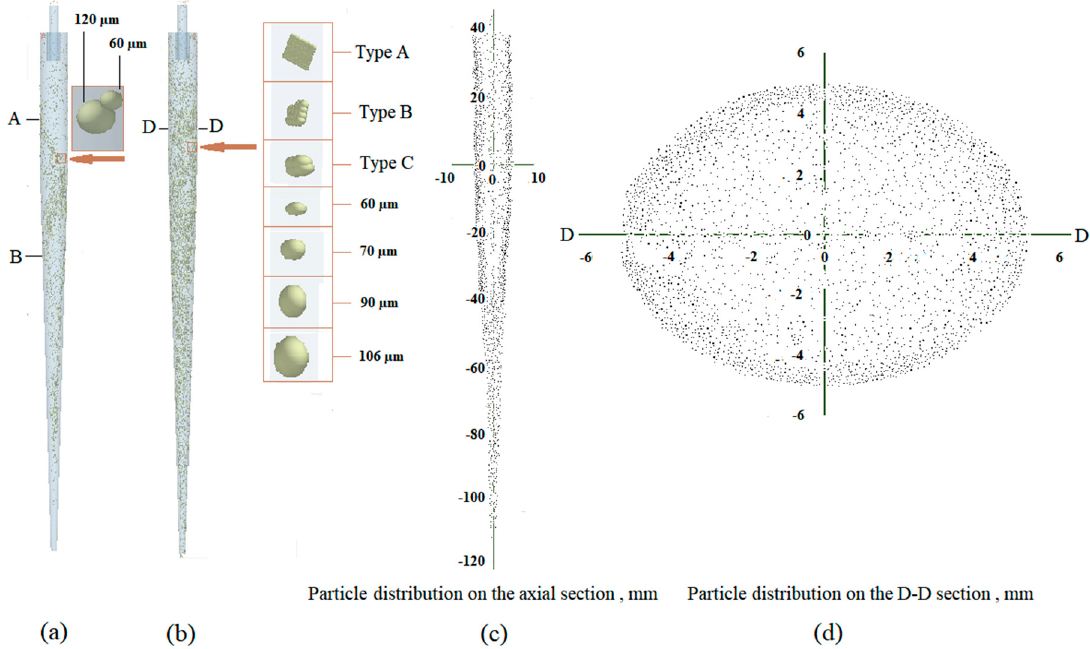
Figure 5. Sand particle distribution in simulation: ( a ) the separation simulation of 60 and 120 µm particles; ( b ) the simulation of the effect of the cross-section change of sand particles in the separation; ( c ) the distribution of sand particles along the Z-axis; ( d ) the particle distribution at the D-D section in ( b ).